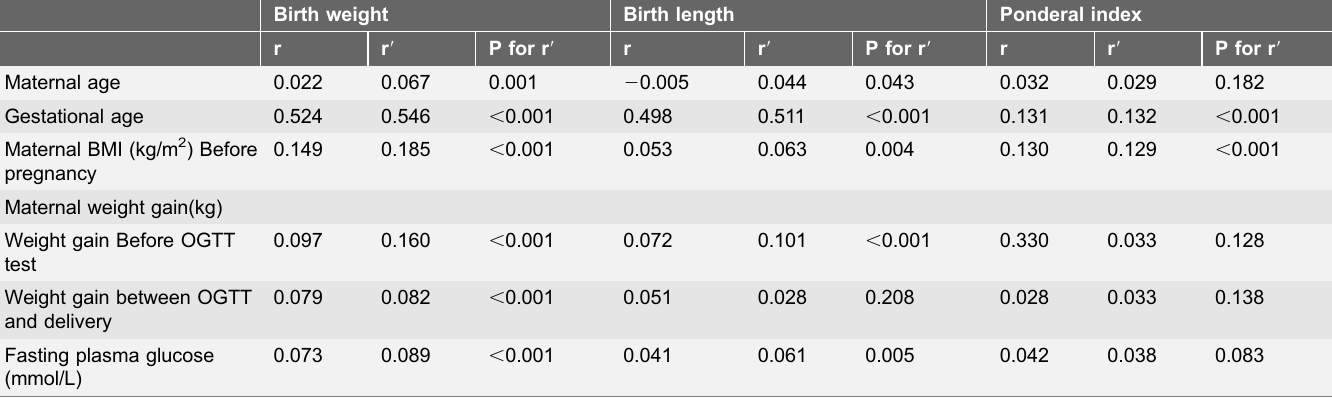
Table 2. Relationship between maternal glycemic metabolism, maternal weight pattern and neonatal birthweight, birth length and Ponderal index. Birth weight Birth